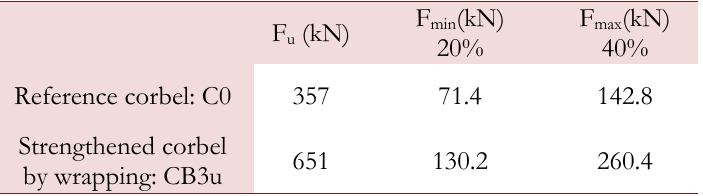
Table 1: Conditions of fatigue load.